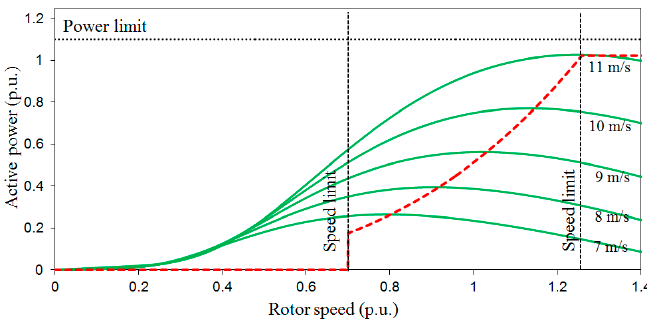
Figure 2. P m curves and P MPT of a DFIG-based WTG.